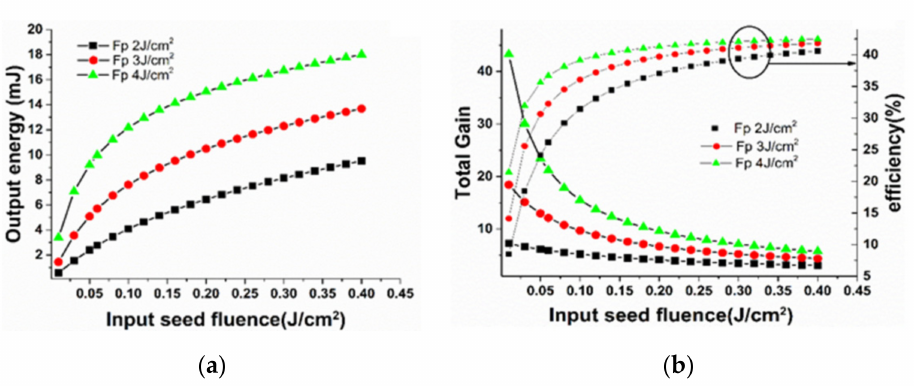
Figure 13. Evolution of the output seed energy ( a ); total gain and energy extraction efficiency ( b ) on the input seed fluence for different pump fluence values.